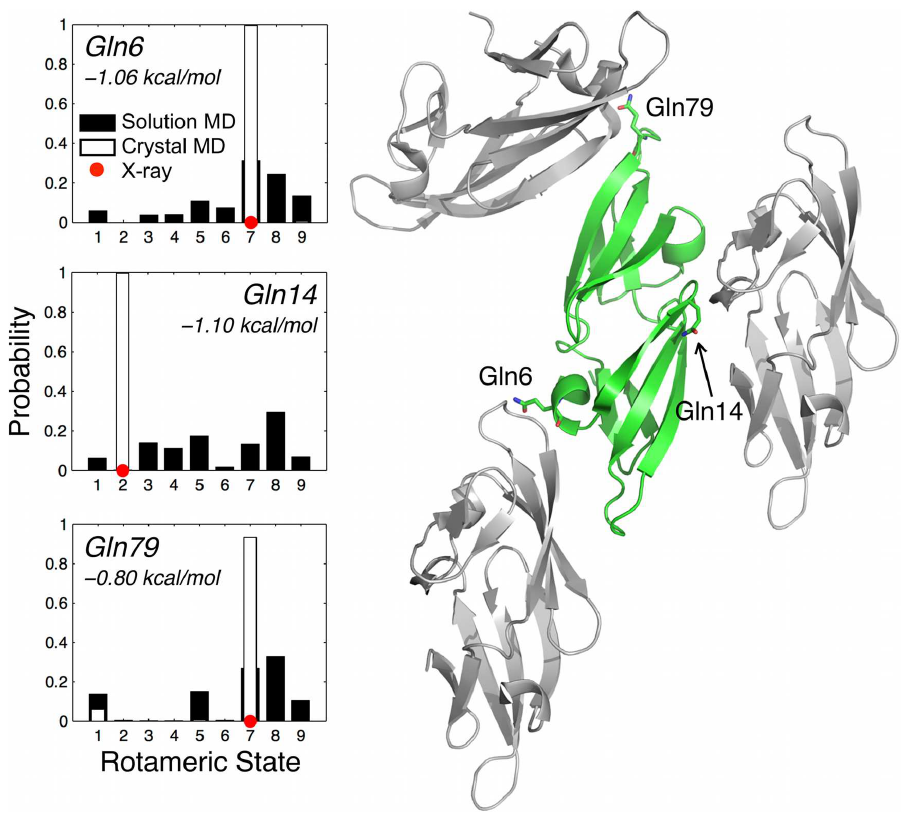
Gln79) are trapped in their respectiveX-ray conformations (red circles on the histograms) duringcrystal MD simulation(white bars), while the residues sample severaldifferent rotamers in solution simulation(black bars). T Δ S conf values are listed under the residue name/number in each histogram. Crystal contacts between these three glutamines and neighboring chains in the crystal are shown at